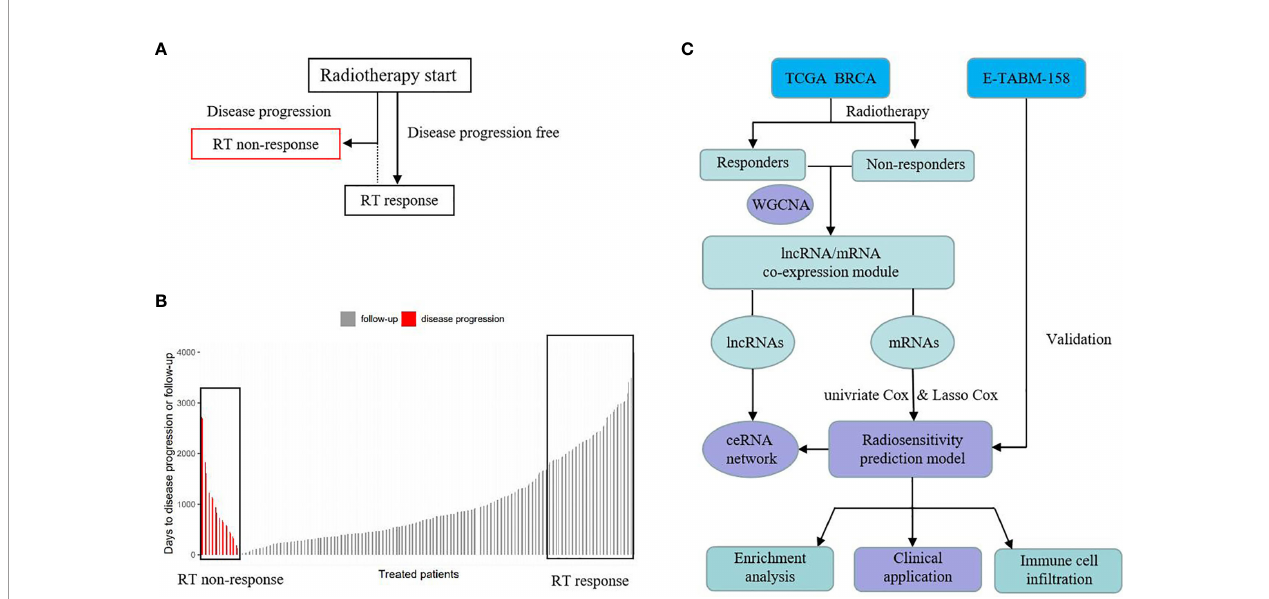
FIGURE 1 | Schematic of study design. (A) The de fi nition of RT response group and RT non-response group. (B) The rank of RT response group and RT non- response group based on time. (C) Analysis